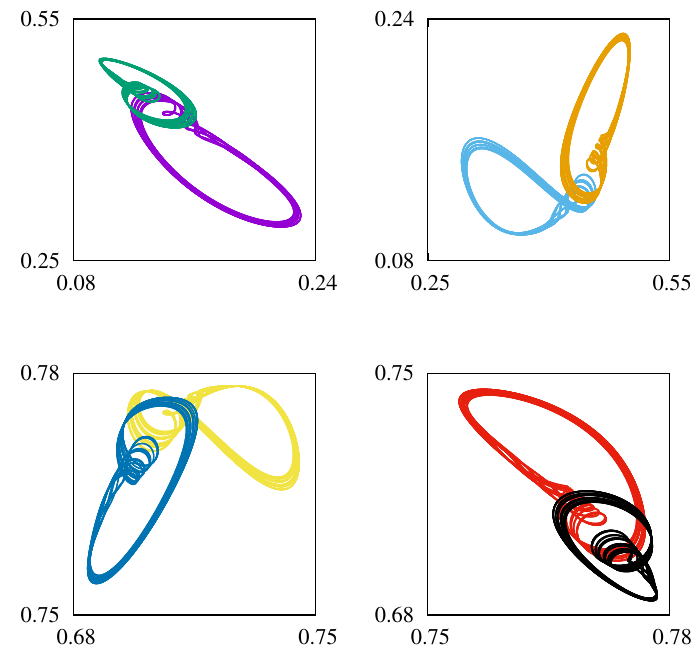
Figure 10. Coexistence of eight chaotic attractors. All of the panels represent a square in the ( x ) -plane, but, for visual clarity, pairs of attractors are plotted in different windows. The parameter 0 , x 2 value is F =